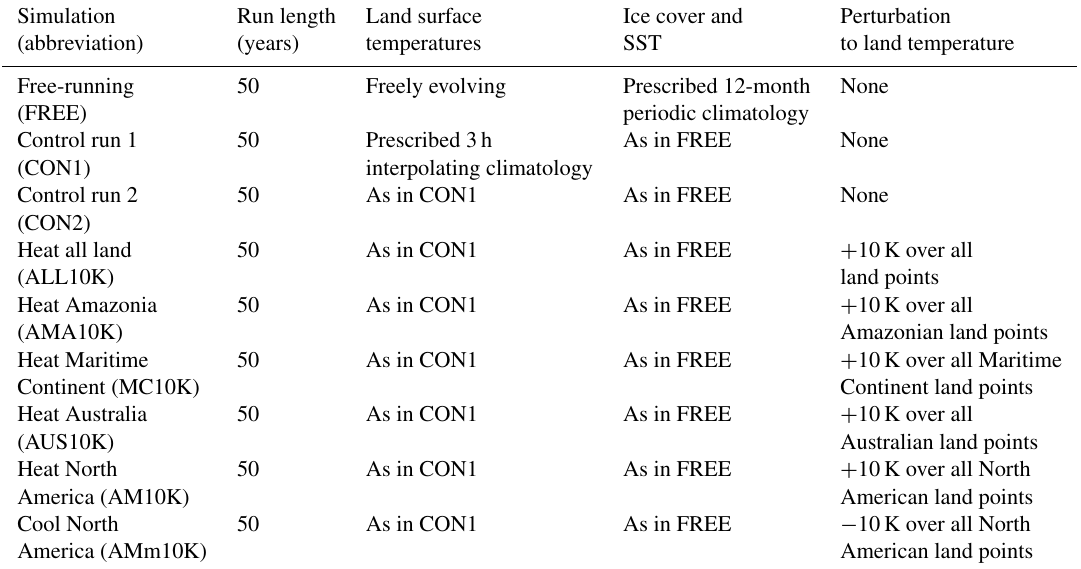
Table 1. A list of the experiments run with ACCESS. The SST and sea ice fractional cover are climatological mean values representative of